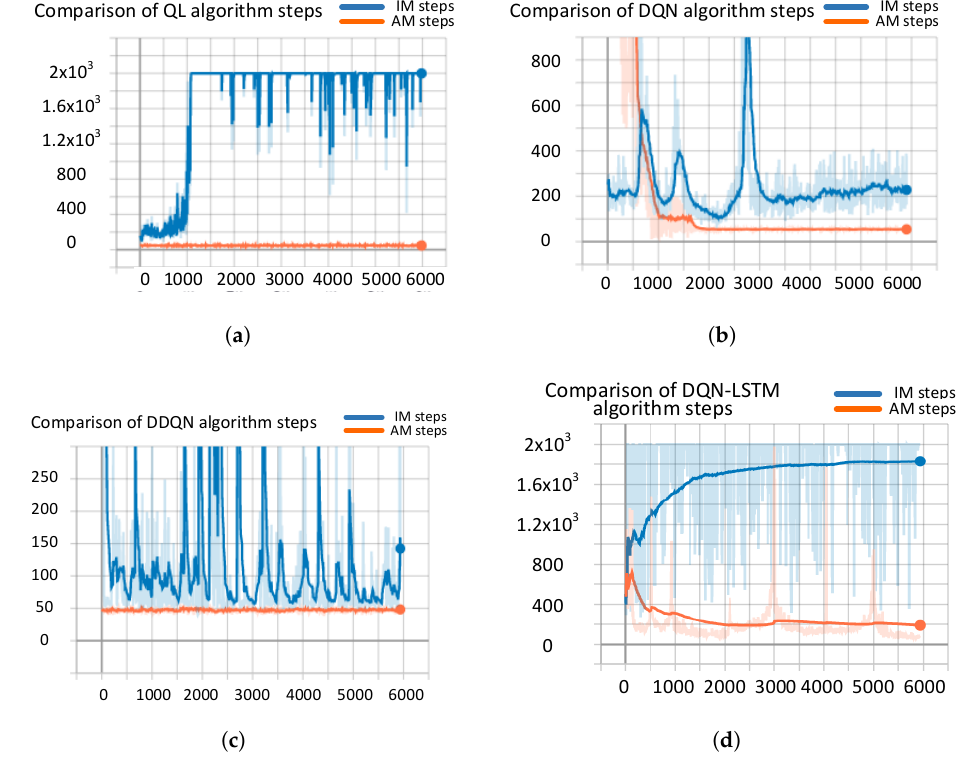
Figure 10. Convergence comparison chart of classical RL algorithms under IM and AM models. ( a ) QL algorithm comparison, ( b ) DQN algorithm comparison, ( c ) DDQN algorithm comparison, ( d ) DQN+LSTM algorithm